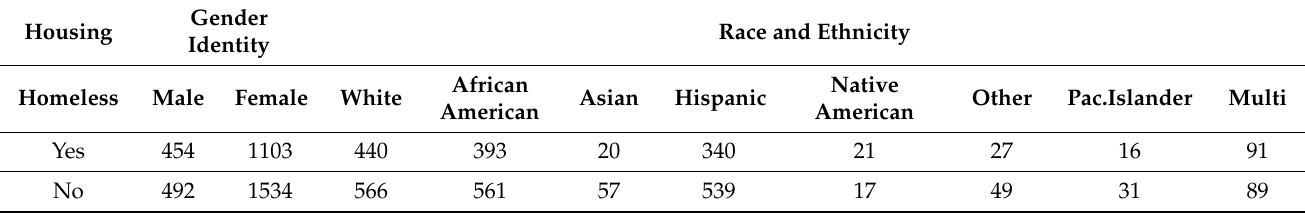
Table 1. Socio-economic distribution of study